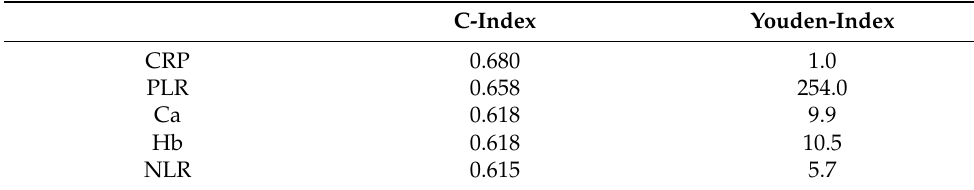
Table 1. Comparison of C-index among serum biomarkers for predicting the lethality in mRCC treated by IPI plus NIVO.